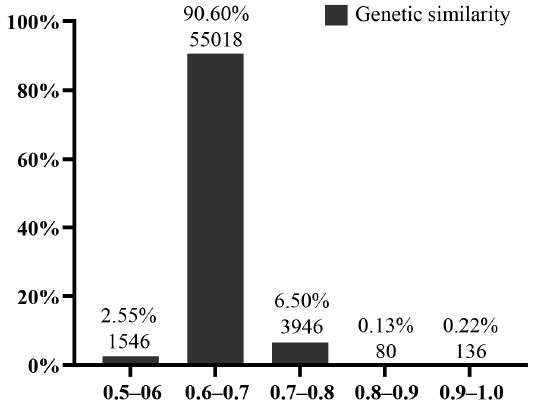
Figure 4. Genetic similarity statistics among 349 tea trees. The numbers in parentheses represent pairs of quantities. Table 1. Analysis of essentially derived varieties (GS > 0.9).